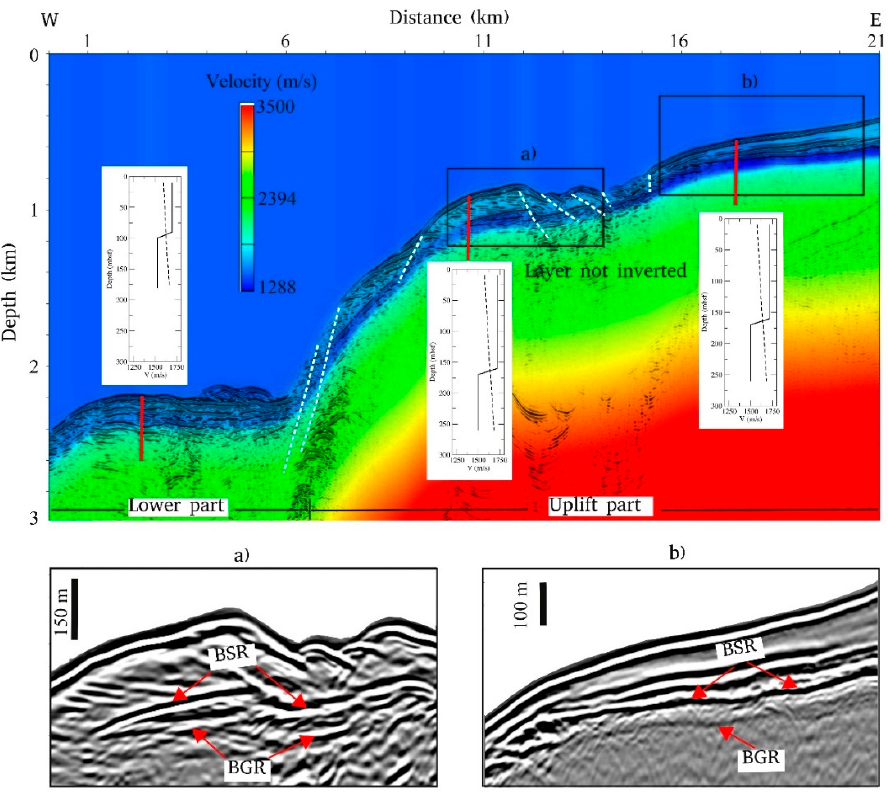
Figure 3. Velocity model superimposed in the Kirchhoff PreSDM section. The three inserts show the modelled velocity curves (solid black lines) and the theoretical curves in the absence of hydrates and free gas (dashed black lines) along the velocity model. Below, the rectangles indicate the position of the zooms in panel (a) and (b), in which red arrows indicate BSR and BGR (if present). The white dotted lines indicate faults and fractures.